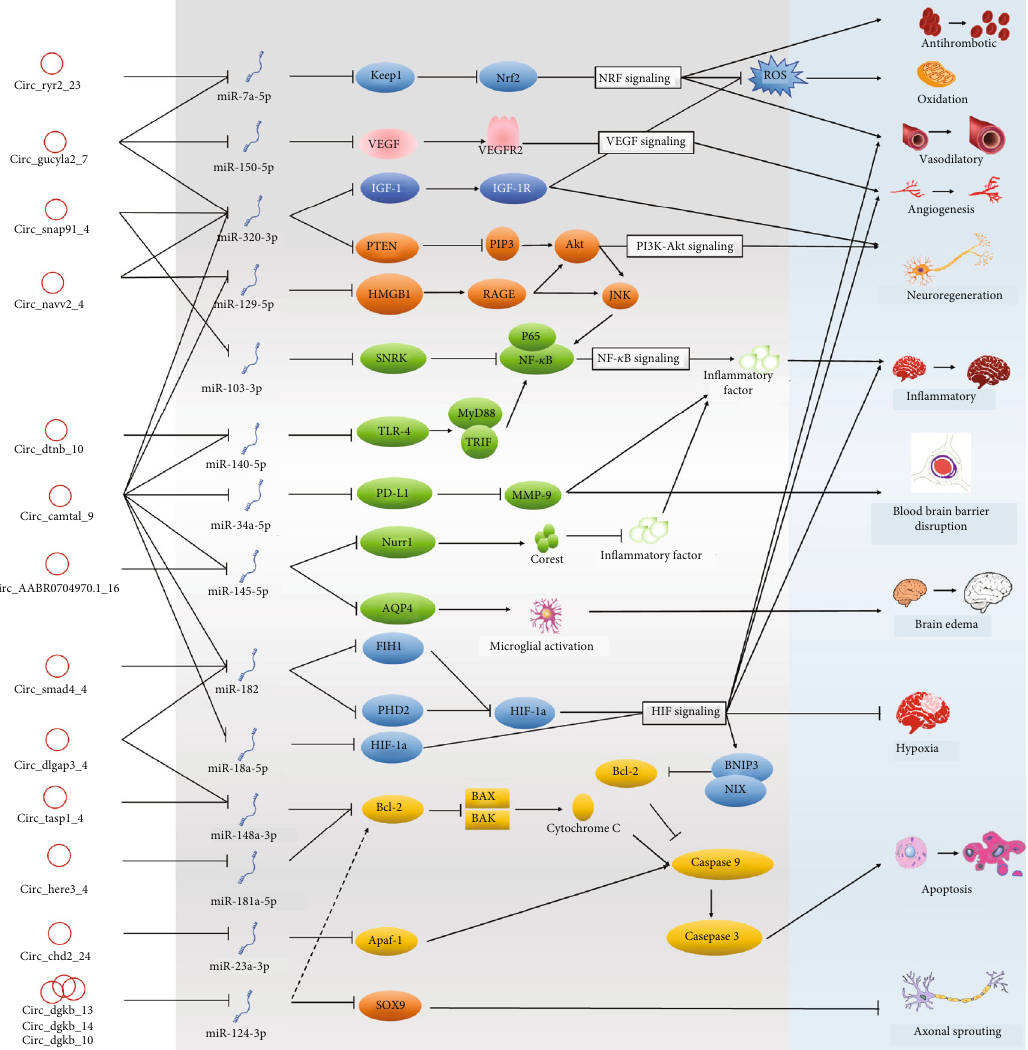
Figure 7: Key candidate circRNAs and their putative biological pathways involved in ischemia and reperfusion injury. The white vertical column lists the key DECs, the light and darker gray vertical columns show the harbored miRNAs and mRNA targets that play important roles in neuroinjury, respectively, and the blue vertical column lists the corresponding biological mechanisms veri fi ed in brain injury following ischemia and